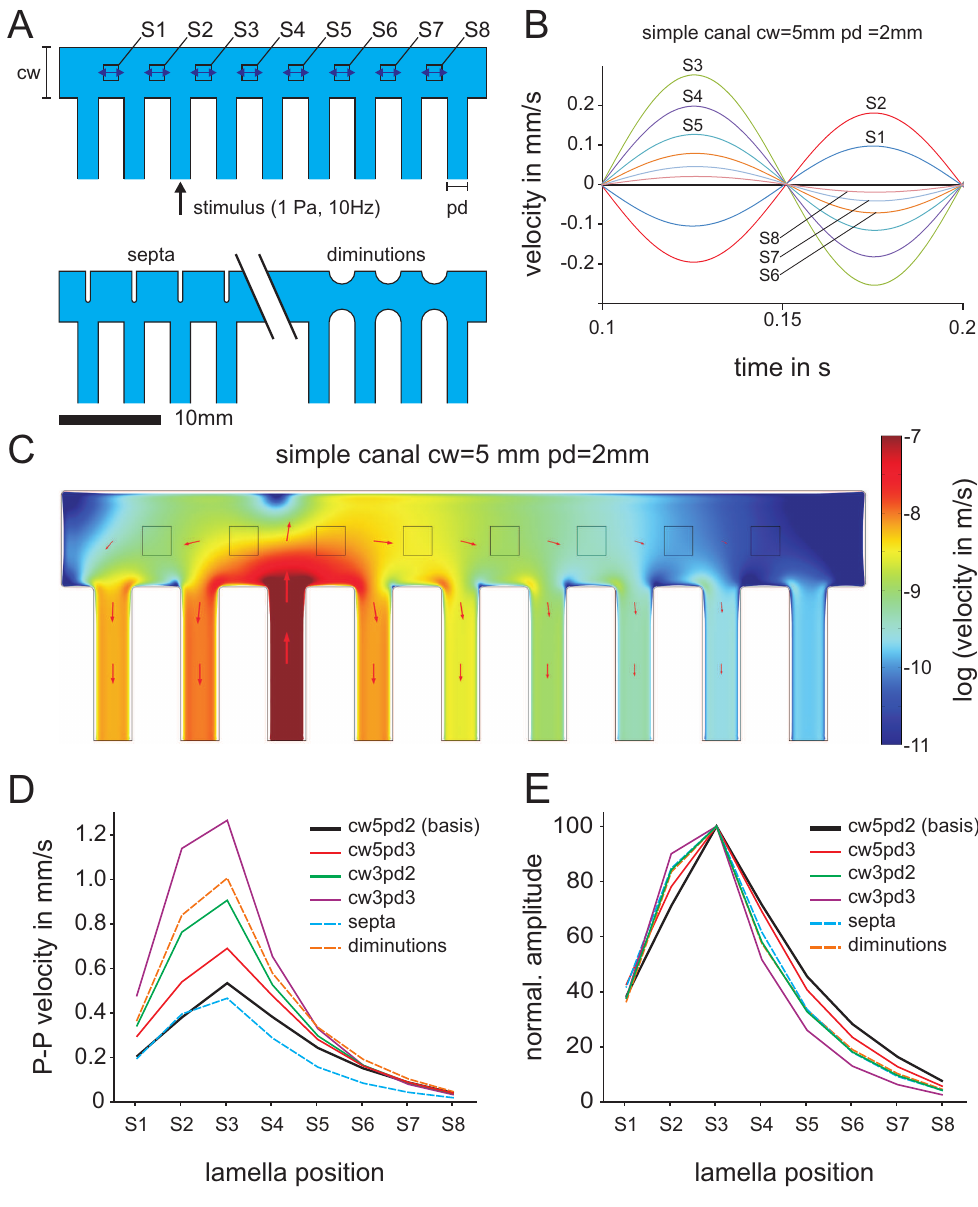
Figure 10. Finite element simulation of mechanical cross-talk induced by the canal geometry. ( A ) Simple canals (top) with variable canal widths (cw) and pore dimensions (pd). Complex canals included septa or diminutions (below). Fluid flow was examined at locations S1 to S8 when stimulated with alternating pressure of 1 Pa at 10 Hz. ( B ) The velocity components in the horizontal direction at locations S1 to S8 (see the double-headed arrows in ( A )). The colors of the curves do not correspond to the colors in ( D )/( E ). ( C ) The flow field inside the basic canal in logarithmic scaling (see also Figure 4A). ( D ) Peak-to-peak amplitudes at locations S1 to S8 for various canal shapes and dimensions (shown in ( A )) ( E ) Normalized peak-to-peak amplitudes from ( D ), referenced to the velocity at location S3. In relation to the basic canal shape, an increase of average flow velocity was found in all canal shapes with the exception of the complex canal featuring septa (Figure 10D; red, green, purple and orange dashed lines are above the bold black line which represents the basic canal). The increase in